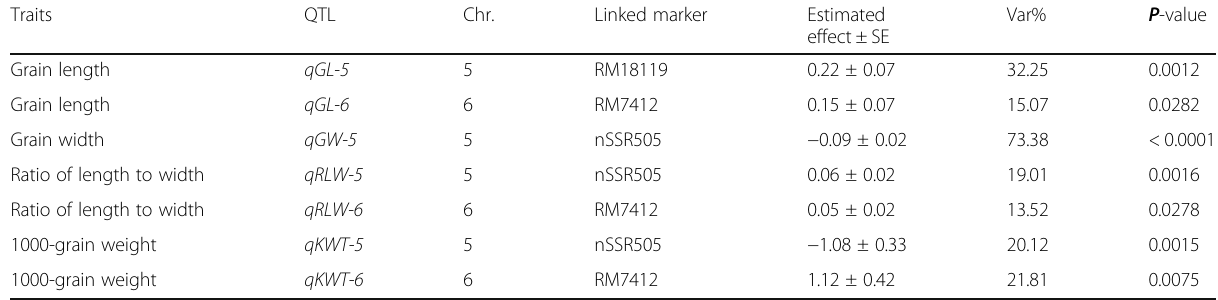
Table 1 QTL mapping for grain size related traits in the secondary F 2 population of Nipponbare /Z1392 Traits QTL Chr. Linked marker Estimated